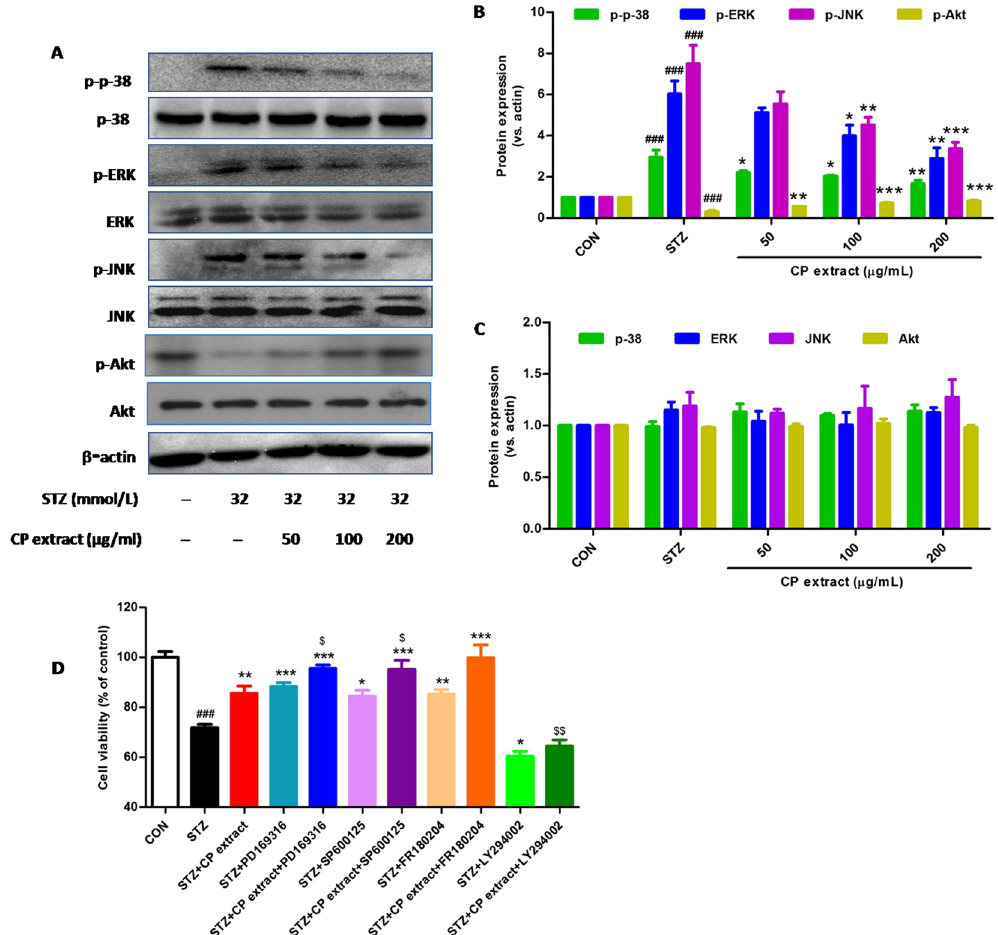
Figure 7. CP extract suppresses MAPK signals and activates Akt signal in STZ-induced NIT-1 cells. NIT-1 cellswere preincubated with CP extract (50, 100 and 200 μ g/mL) for 2 h before 32 mM STZ treated for 24 h. Cells were lysed and then the expression of proteins in MAPK and Akt signaling pathways were measured using Western blot. ( A ) Representative image of Western blot; ( B and C ) Protein expressions of p-p38, p38, p-ERK, ERK, p-JNK, JNK, p-Akt and Akt in NIT-1 cells. ( D ) NIT-1 cells were preincubated with CP extract (100 μ g/mL) or PI3K inhibitor (LY294002, 1.25 μ M) or ERK inhibitor (FR180204, 1.25 μ M) or p-38 inhibitor (PD169316, 1.25 μ M) or JNK inhibitor (SP600125, 1.25 μ M) or combnation of both CP extract and LY294002 or FR180204 or PD169316 or SP600125 for 2 h before 32 mM STZ treated for 24 h, then the cell viability was assessed by MTT assay. Data were expressed as mean ± SEM from three independent experiments. ### p < 0.001, compared with untreated control group; * p < 0.05, compared with STZ-treated group; $ p < 0.05 and $$ p < 0.01, compared with STZ + CP extract group using Student’s